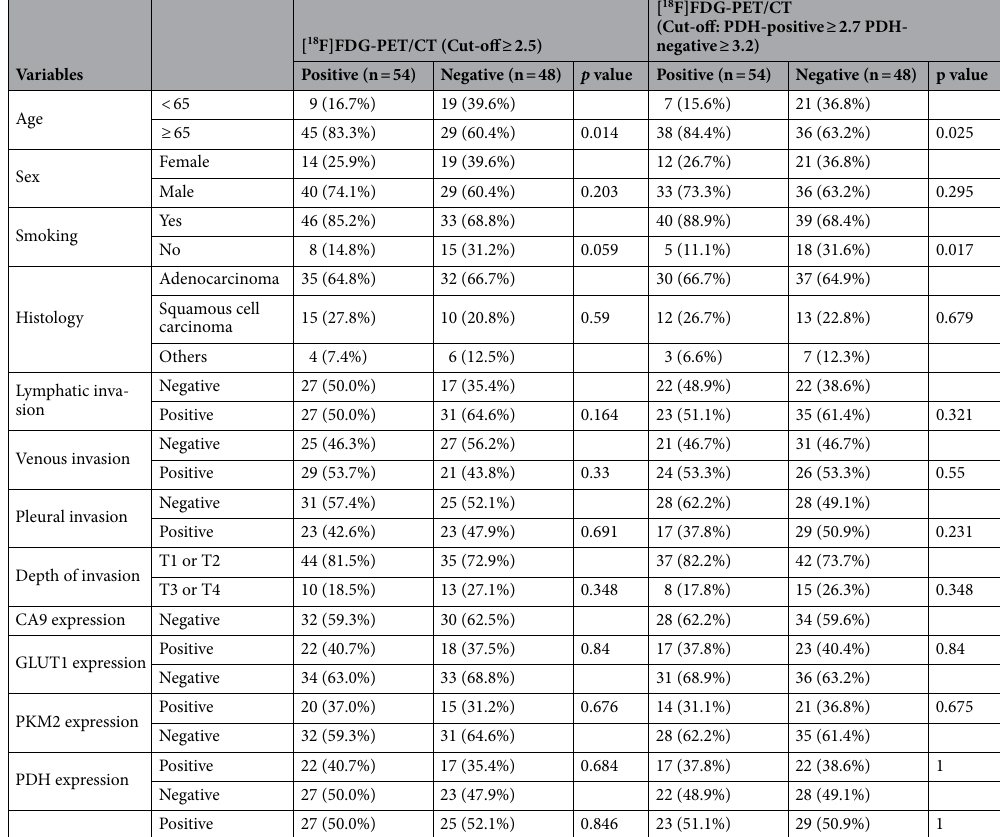
Table 2. Relationship between [ 18 F]FDG-PET/CT and clinicopathological features in 102 patients with lung cancer and lymph node metastasis. [ 18 F]FDG-PET/CT, [ 18 F]fluorodeoxyglucose positron emission tomography/computed tomography; PDH–E1α, pyruvate dehydrogenase E1α; CA9, carbonic anhydrase 9; GLUT1, glucose transporter-1, PKM2; pyruvate